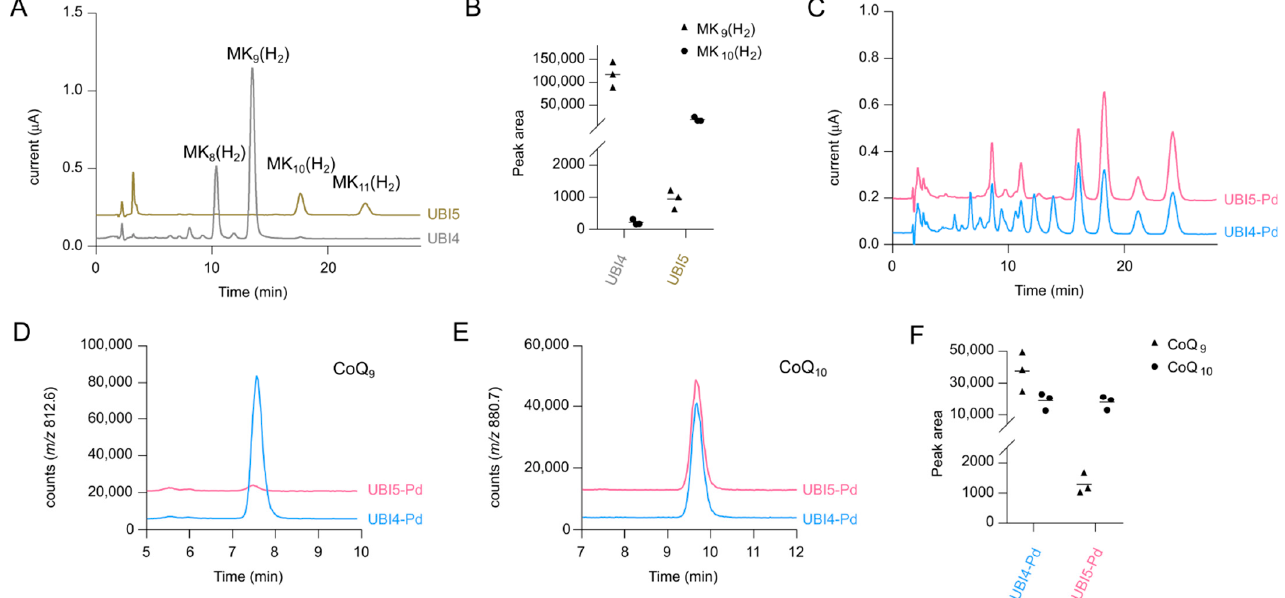
Figure 2. ( A ) Overlay of electrochemical detection (ECD) chromatograms from extracts of strains UBI4 and UBI5. The peaks corresponding to MK 8-11 (H 2 ) are marked. ( B ) Quantification of MK 9 (H 2 ) and MK 10 (H 2 ) (MS peak area) in three independent samples of UBI4 and UBI5 cells. ( C ) Overlay of ECD chromatograms from extracts of strains UBI4-Pd and UBI5-Pd. ( D , E ) Overlay of SIM chromatograms for CoQ 9 (NH 4+ adduct m / z = 812.6, D ), CoQ 10 (NH 4+ adduct m / z = 880.7, E ). Chromatograms are representative of three independent samples. ( F ) Quantification of CoQ 9 and CoQ 10 (MS peak area) in three independent samples of UBI4-Pd and UBI5-Pd cells.